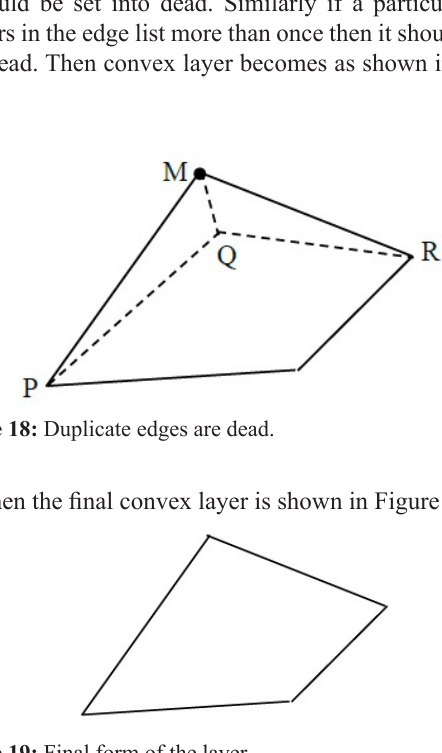
Figure 19: Final form of the